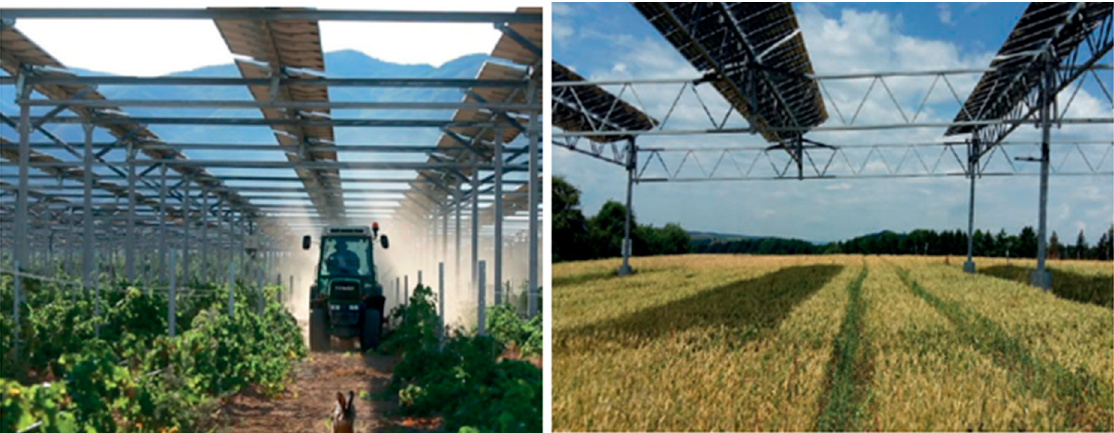
Figure 6. Spacing between rows of panels allowing movement of farm machinery under the PV panels © Fraunhofer ISE [44].